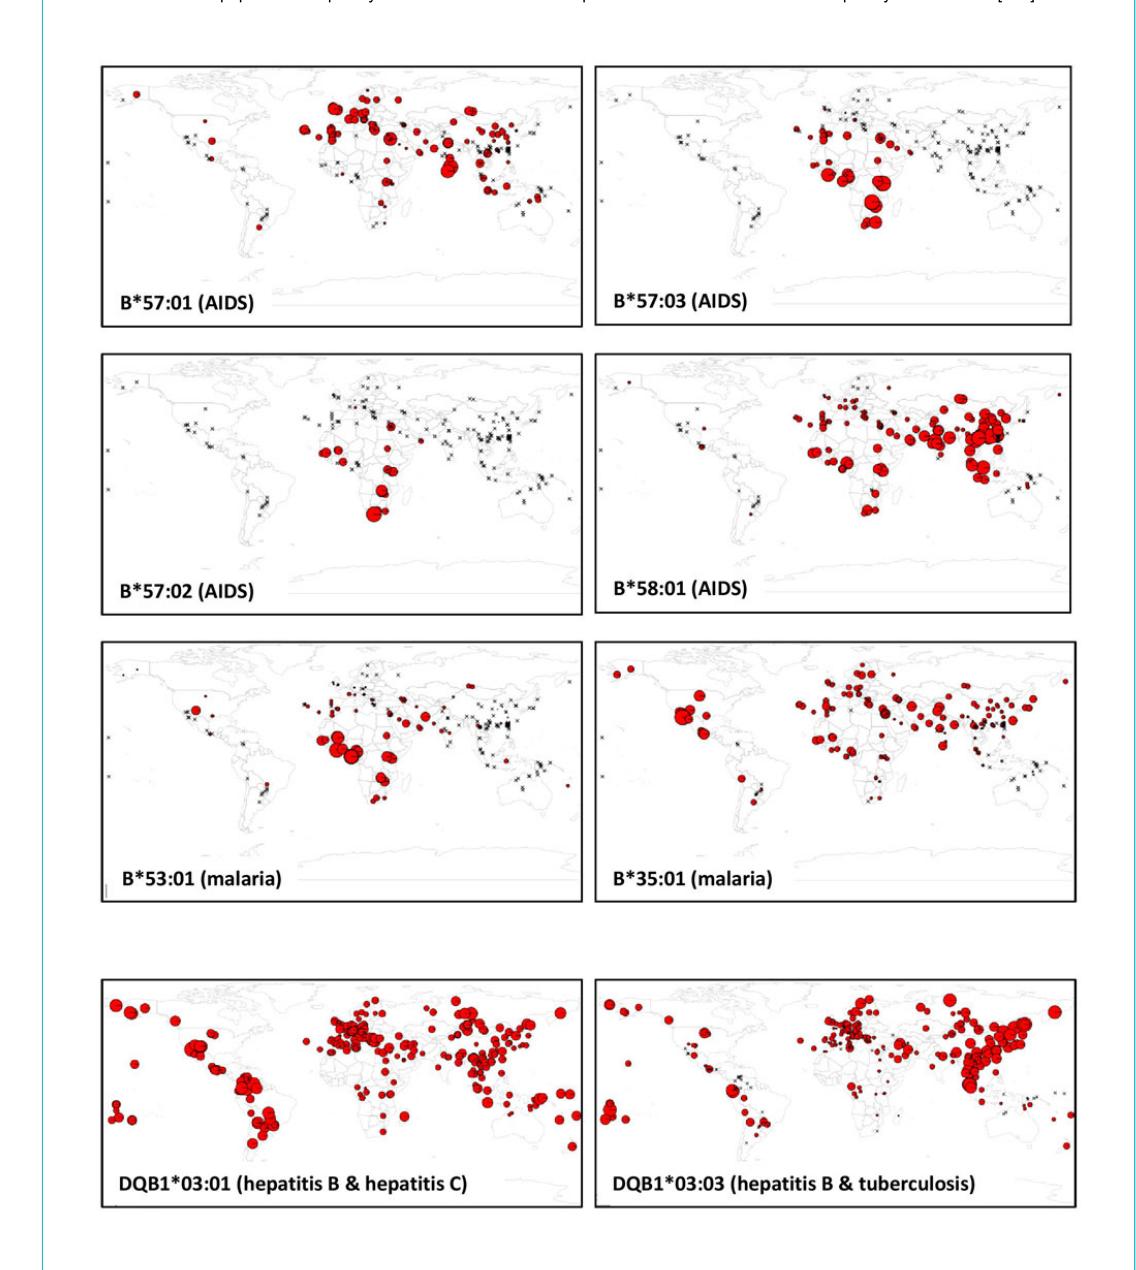
Figure 2: Worldwide population frequency maps of some of the HLA-B alleles suggested to confer protection against AIDS (B*57:01, B*57:02, B*57:03, B*58:01) and malaria (B*53:01, B*35:01) as well as of two HLA-DQB1*03 alleles suggested to be associated to hepatitis B suscepti- bility (DQB1*03:01 and DQB1*03:03), to hepatitis C protection (DQB1*03:01) and to tuberculosis susceptibility (DQB1*03:03) (see text for ref- erences).In each map, the sizes of the pie charts are proportional to the frequencies of the allele in the corresponding populations, but pie charts are not at the same scale in the different maps. The maximum size of the pie charts in each map correspond to the following frequen- cies: B*57:01 = 0.082 (Tamil from South India; South Asia); B*57:02 = 0.042 (Xhosa from South Africa, sub-Saharan Africa); B*57:03 = 0.057 (Lusaka from Zambia, sub-Saharan Africa); B*58:01 = 0.170 (Han, China, East Asia); B*53:01 = 0.244 (Angolan, Sao Tome Island, sub-Saha- ran Africa); B*35:01 = 0.485 (Seri, Mexico, North America); DQB1*03:01 = 0.896 (Gila River Amerindian from Arizona, North America); DQB1*03:03 = 0.313 (Jehai from Malaysia, Southeast Asia).In each map, the crosses represent HLA-tested populations where the allele was not observed.All HLA population frequency data were taken from both published articles and the allelefrequency.net database